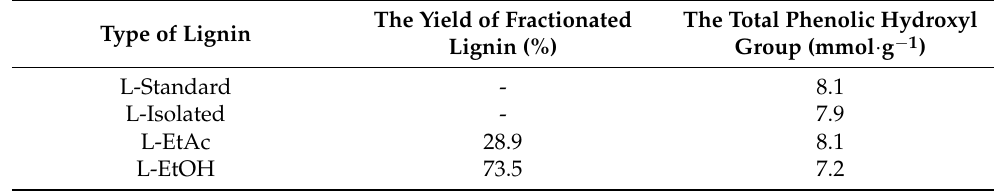
Table 2. Yield and total OH phenolic of fractionated